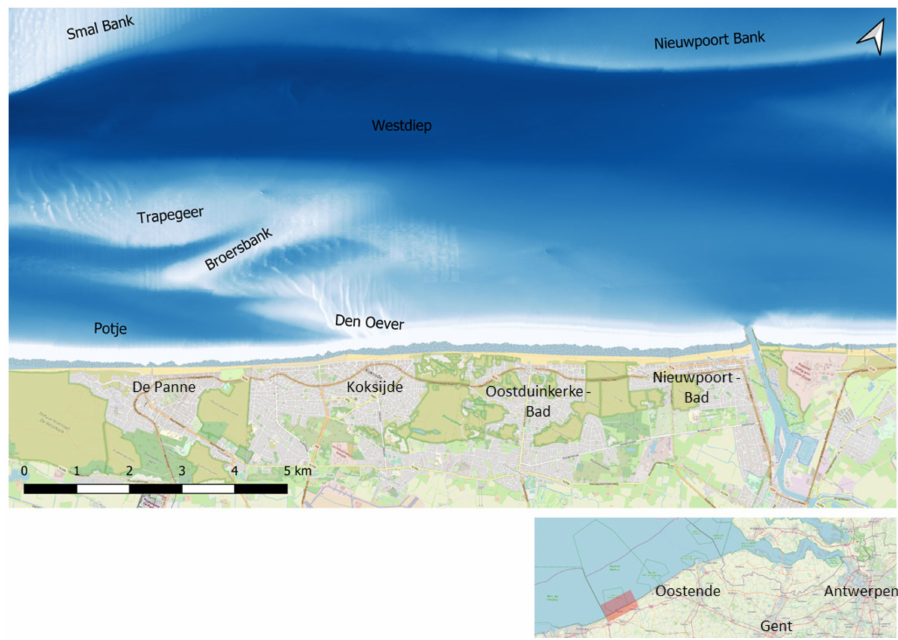
Figure 2. Sand banks and gullies in front of the study area. The location of the study area in Belgium is shown on the small map (red